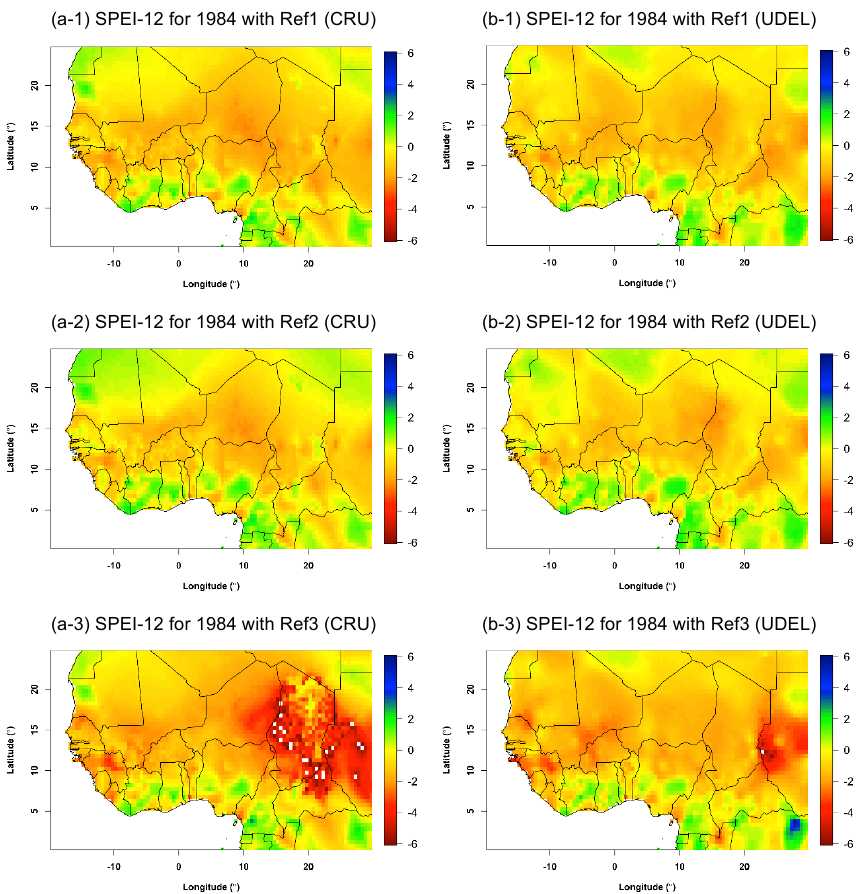
Figure 16. Spatial distribution of SPEI-12 for three different reference periods (Ref1, Ref2 and Ref3 in Table 2) based on the (a) CRU and (b) UDEL datasets in West Africa in 1984 as an